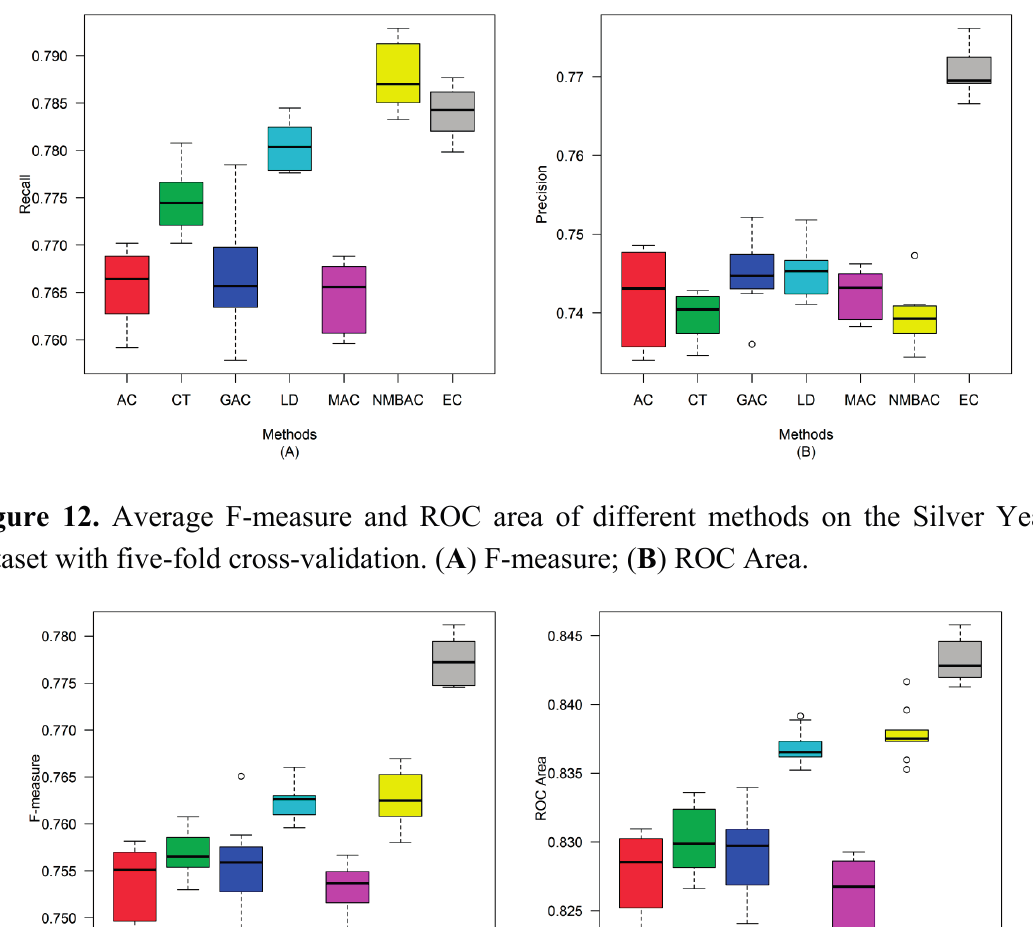
Figure 11. Average Recall and Precision of different methods on the Silver Yeast dataset with five-fold cross-validation. ( A ) Recall; ( B ) Precision.